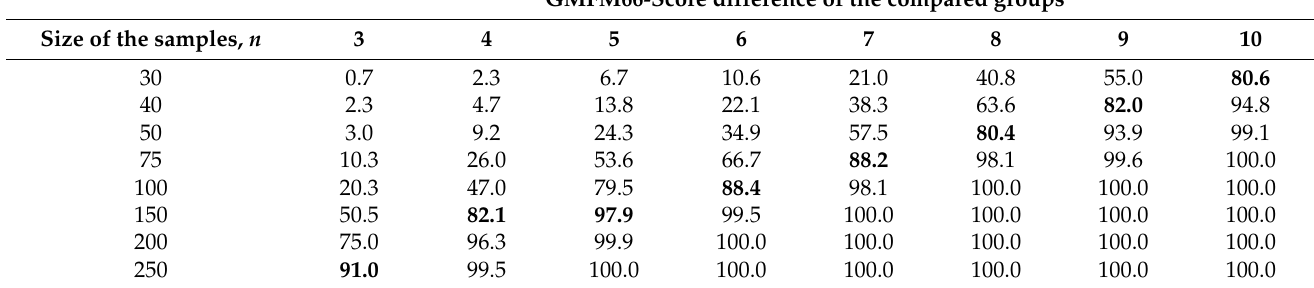
Table 3. Cont . Power of Medical Device-Score GMFM66-Score difference of the compared